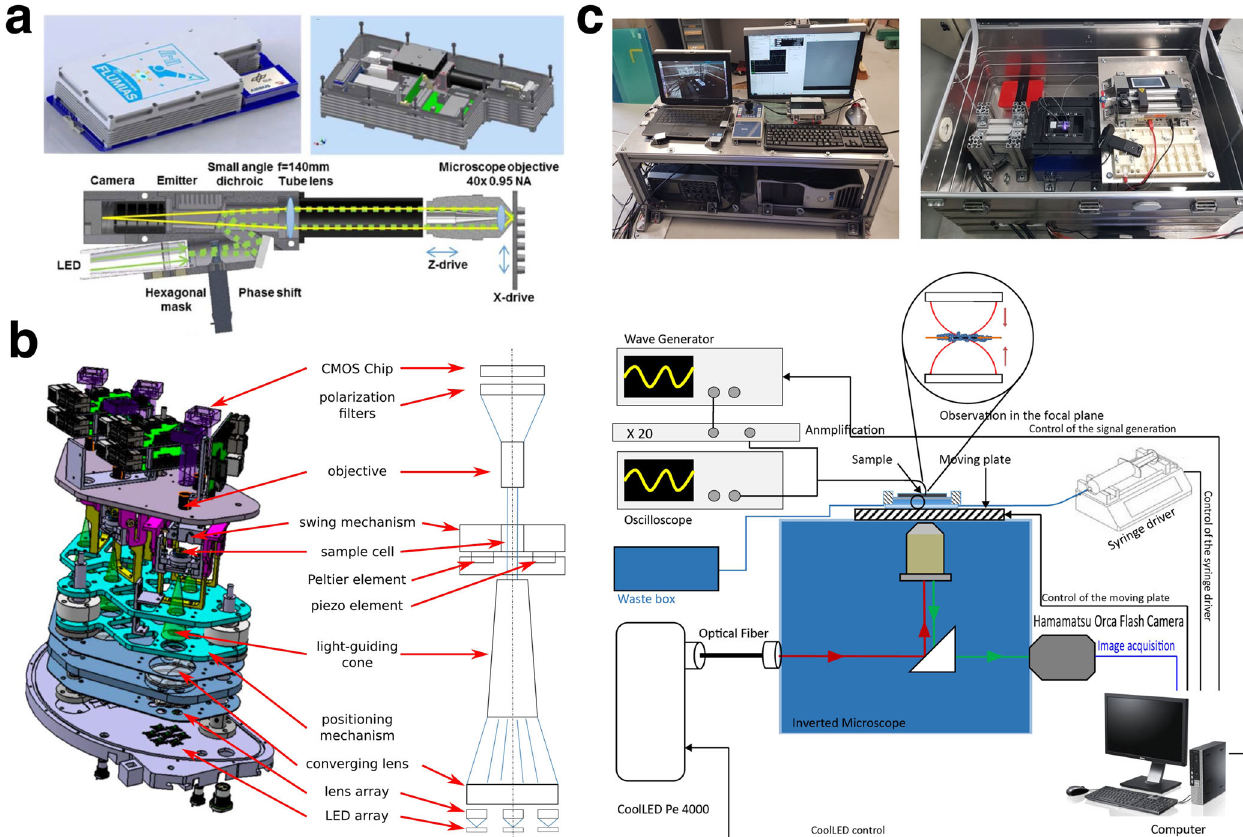
Fig. 3 Examples of optical microscopy setups for microgravity research. a FLUMIAS is a miniaturised high-resolution 3D fl uorescence microscope coupled to a centrifuge on the International Space Station (ISS) for live cell imaging. FLUMIAS can therefore be operated in microgravity as well as in controlled arti fi cial gravity conditions with an effective gravitational acceleration of up to 1.1× g . Reprinted from C. S. Thiel et al. 27 ; use permitted by authors of original publication. b The RAMSES fl ight platform is designed for the sounding rocket MAPHEUS to study the motion of self-propelled particles in space. Reprinted from R. Keßler et al. 71 , with the permission of AIP Publishing. c Optical microscopy setup used on the Airbus Zero-G for the acoustic manipulation of dense gold nanorods samples in microgravity. Reprinted by permission from Springer Nature Customer Service Centre GmbH: Springer, G. Dumy et al. 76 , Copyright 2020 Springer